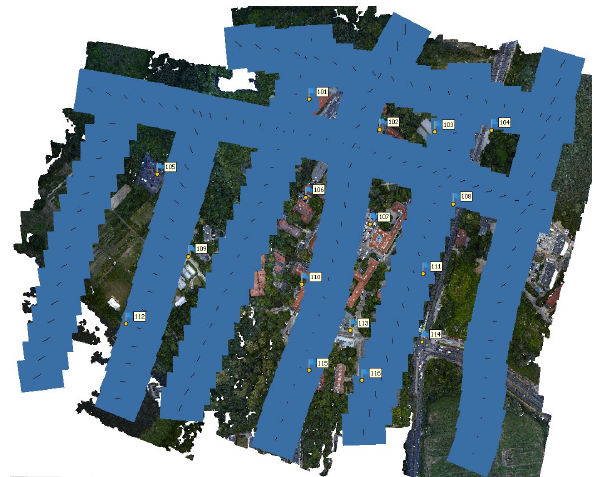
Figure 5. Flight arrangements on subblock of the Kortowo